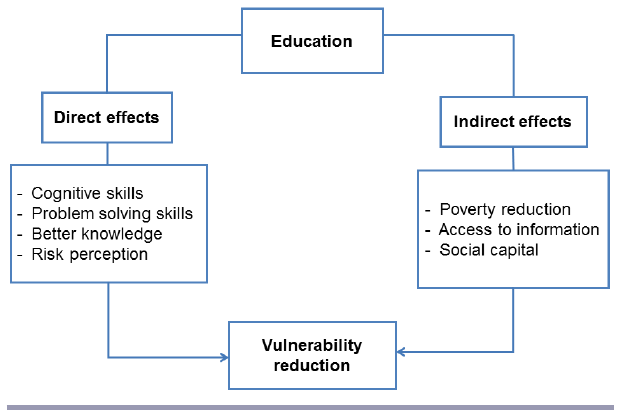
Fig. 1 . Flowchart displaying the processes through which education contributes to vulnerability